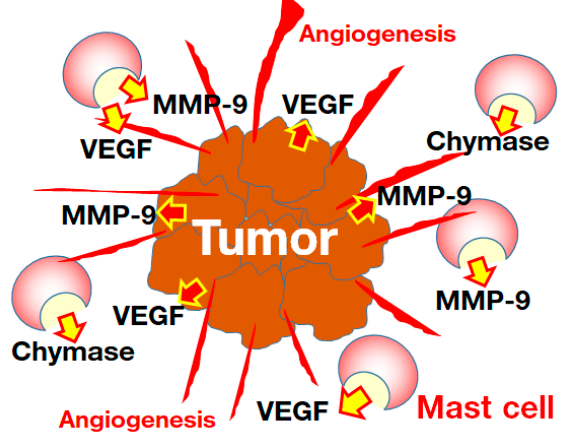
Figure 3. Tumors secrete VEGF and MMP-9, both of which contribute to angiogenesis in the TME; mast cells also release VEGF and MMP-9, in addition to chymase, after their activation.